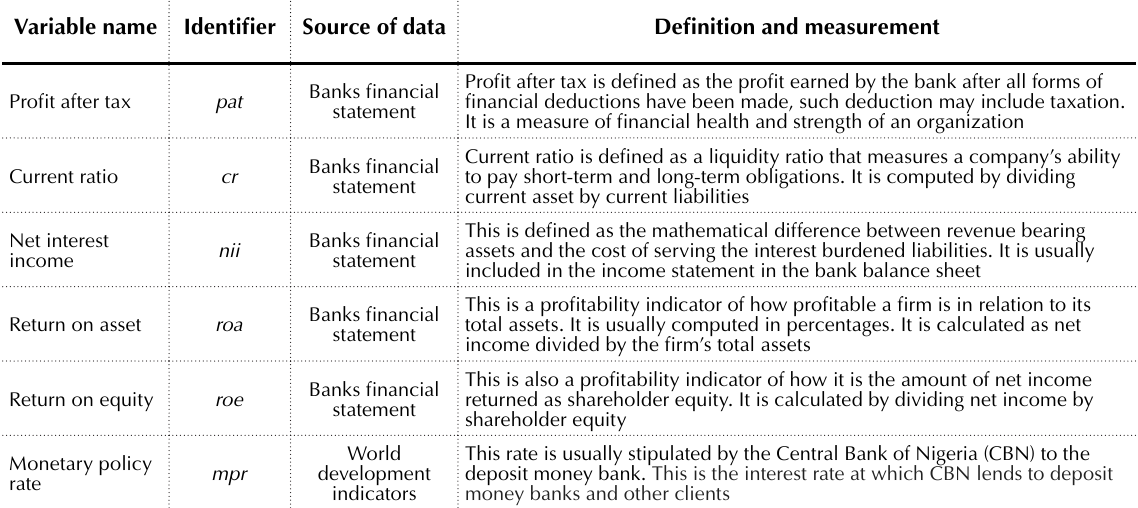
Table 2. Summary statistics of variables